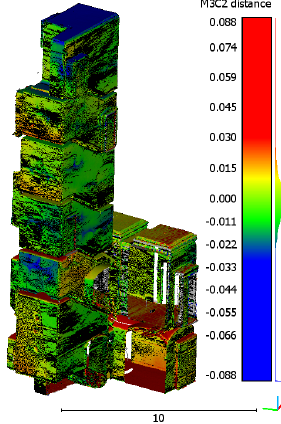
Figure 9. Representation of the MMS segments (left), and M3C2 results (right).